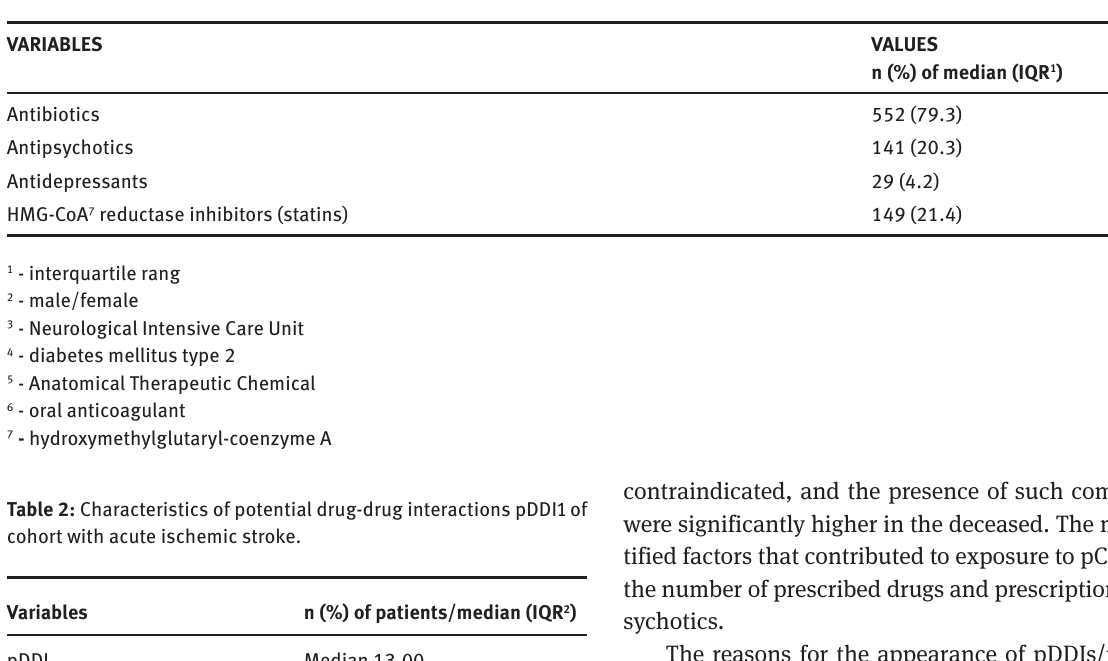
Table 1 continued: Characteristics of cohort with acute ischemic stroke.